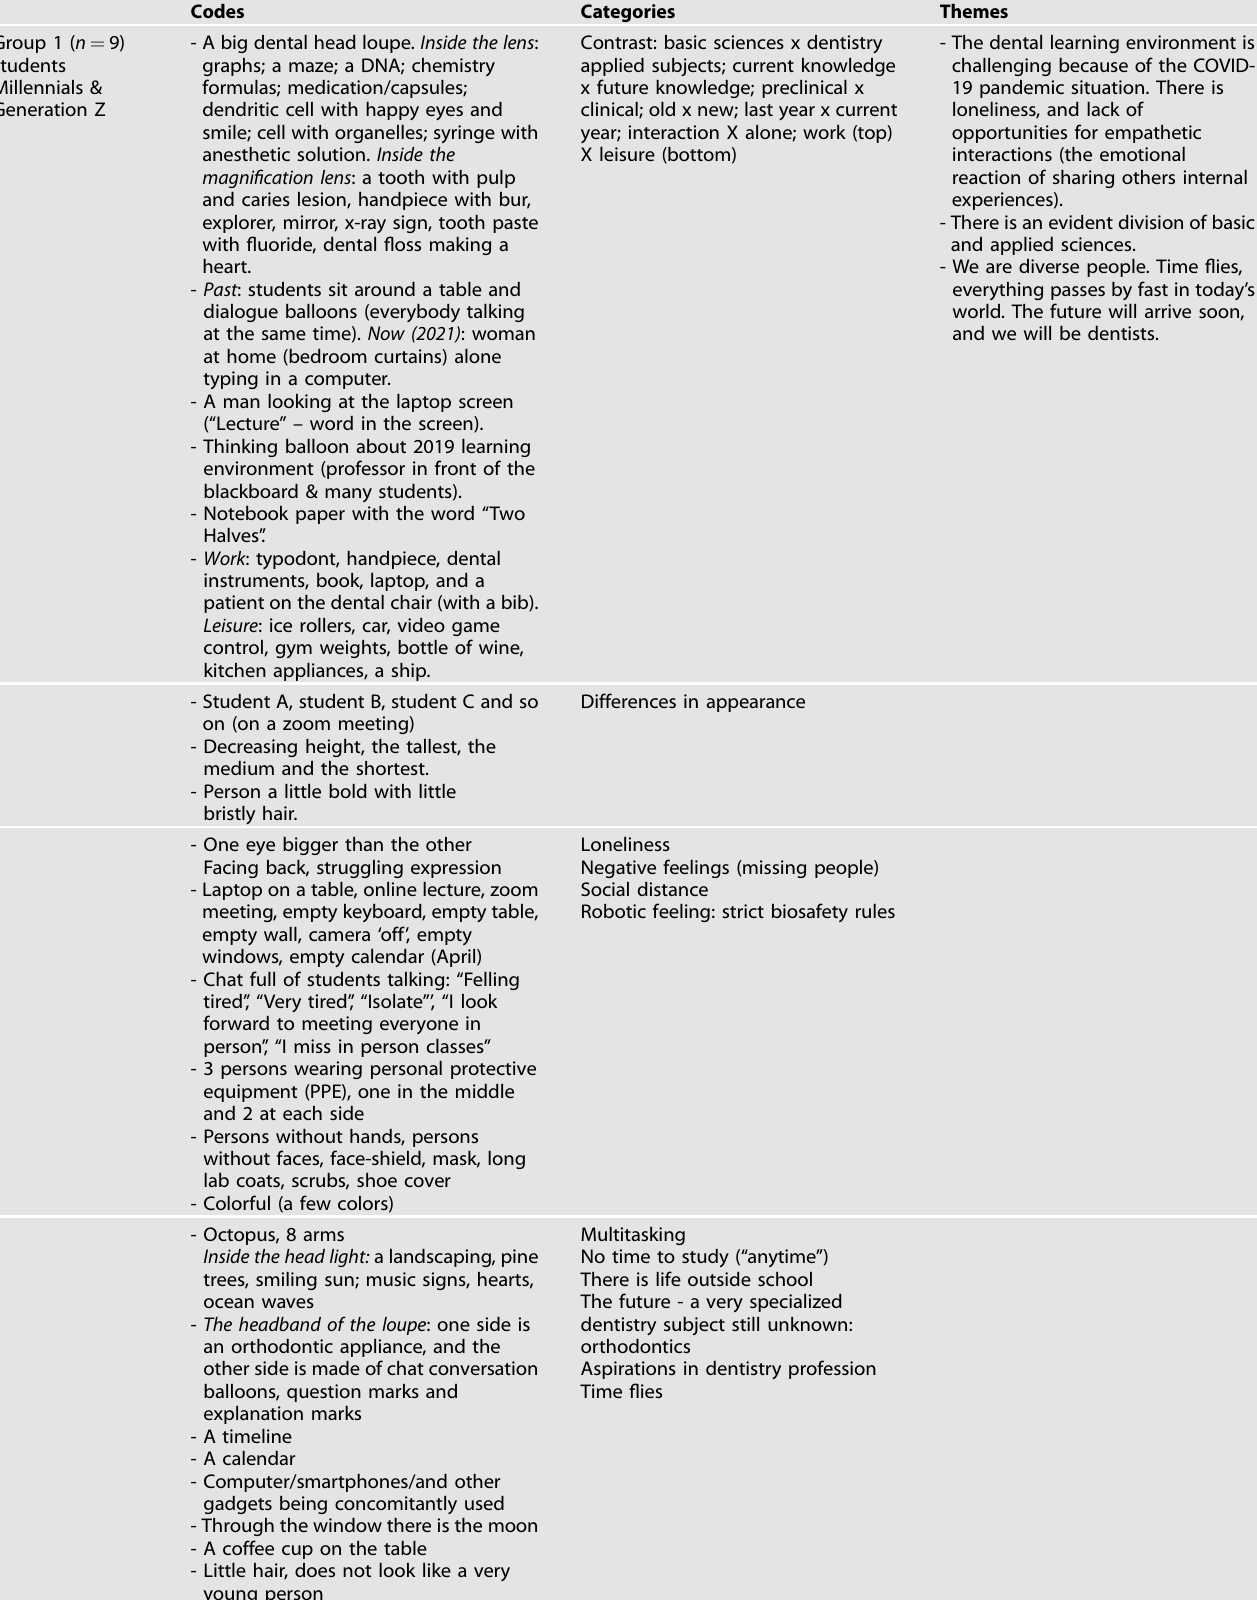
Table 2. Codes, categories, and themes resulting from graphical data collected from the drawings, independently for dental students and dentistry faculty